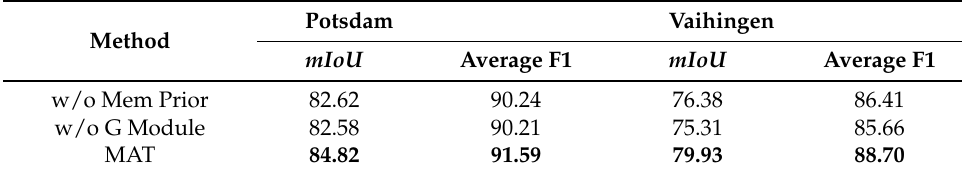
Table 3. Ablation results on the Potsdam and Vaihingen datasets. w/o Mem Prior denotes the model without the memory prior, and w/o G Module denotes the model without the global branch. Bold type indicates the best